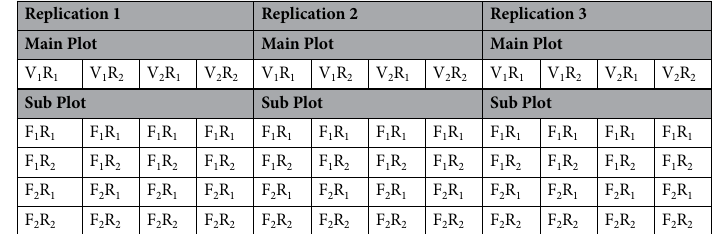
Table 6. Experimental layout for evaluation of paddy-developed residue management machine.